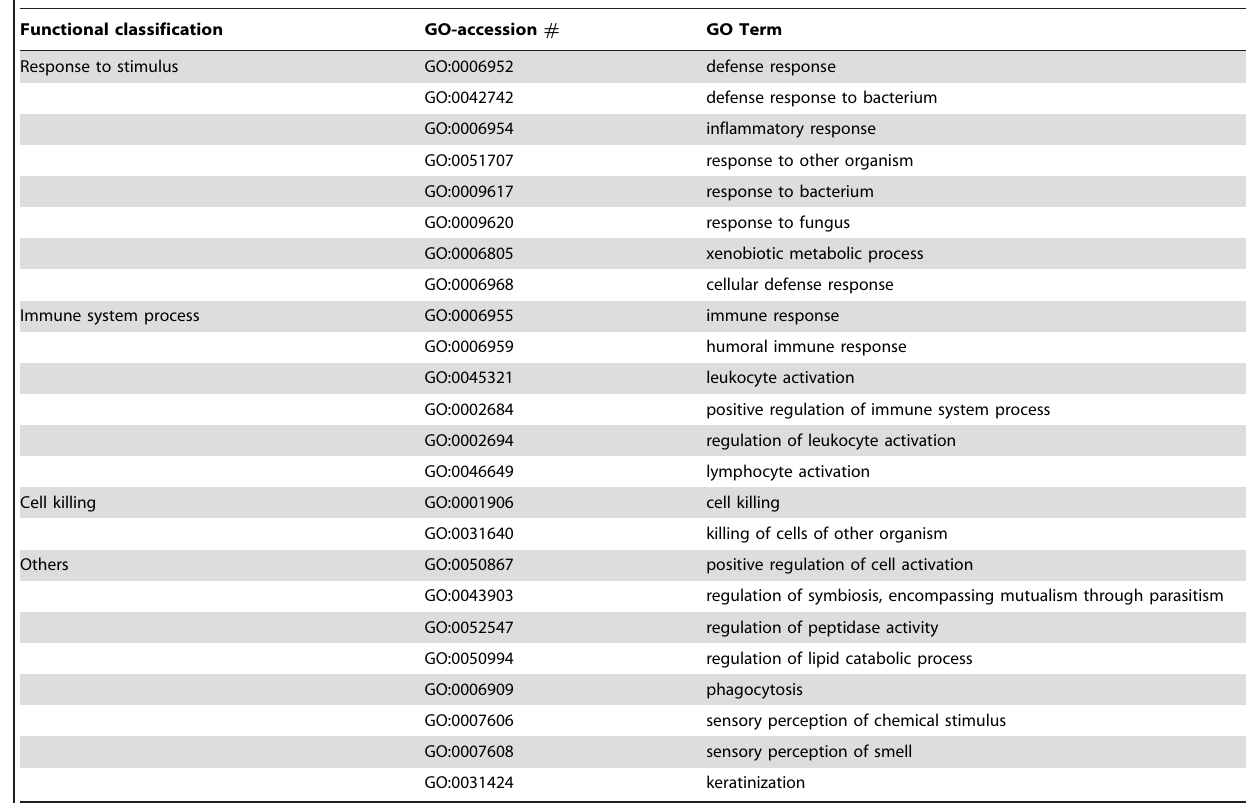
Table 2. Hypomethylation-specific functions.